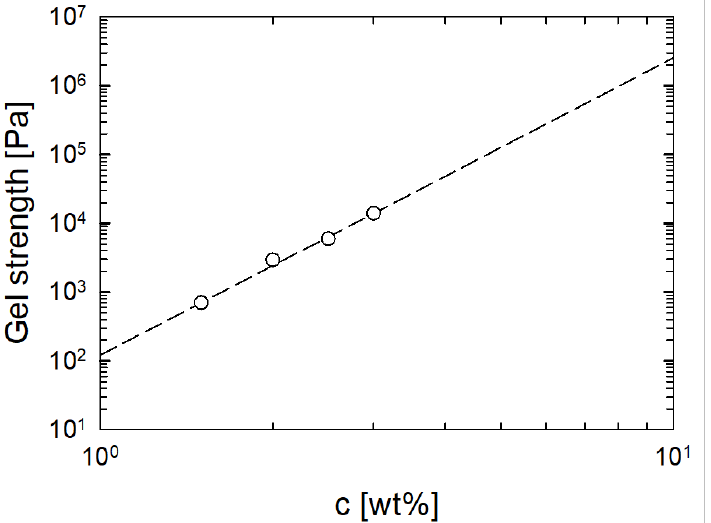
Figure 6. Elastic modulus at 20 ◦ C, as a function of κ -c concentration. Empty circles are experimental data and the dashed line is the power-law regression obtained via Equation